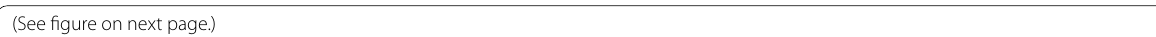
figure on next Fig. 2 SP1 was the direct target of miR-199a. a Bioinformatics-based target analysis showed that SP1 is a potential target of miR-199a. b Luciferase reporter assay showed that the luciferase activity of SP1 3 ′ UTR-wt significantly decreased with miR-199a mimic transfection, comparing to that of the NC mimic or SP1 3 ′ UTR-mutant group (n 3). c–e In the HG-treated cells, the mRNA and protein expression of SP1 increased significantly = compared to NG control cells (n 9). f The level of miR-199a was increased with miR-199a mimic transfection and decreased in the inhibitor group, = compared with the normal cells, or negative control mimic/inhibitor. Meanwhile, lipofectamine (Lipo Ctr) did not affect miR-199a expression (n g–i SP1 mRNA and protein levels were downregulated significantly with the miR-199a mimic transfection, while they were upregulated when miR-199a was inhibited (n 9). SP1 specific protein 1, HG high glucose, Lipo Ctr only lipofectamine treated as the lipofectamine control. * P < =